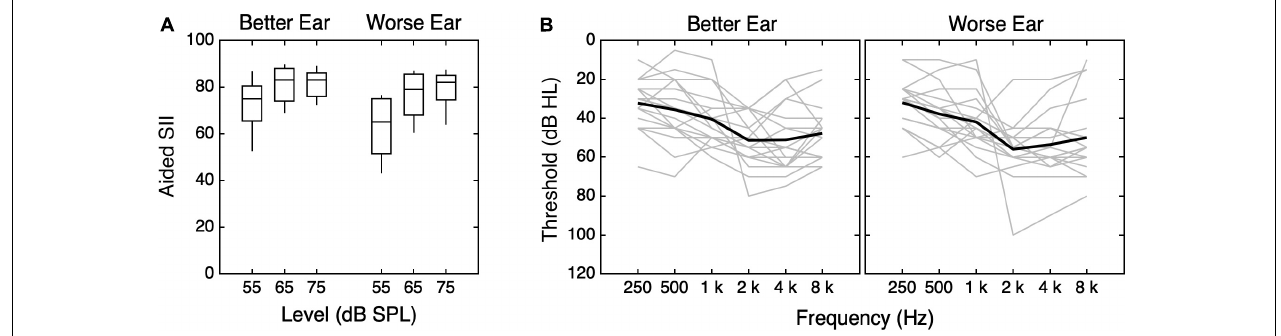
FIGURE 3 | Values of (A) SII and (B) pure-tone thresholds for children with hearing loss (CHL). (A) The distribution of SII is plotted as a function of stimulus level, with results shown separately for the better and worse ears, as indicated at the top of the panel. Horizontal lines indicate the median, boxes span the 25th to 75th percentiles, and vertical lines span the 10th to 90th percentiles. (B) Pure-tone thresholds for the better and worse ears are shown. Better and worse ear were identified for each subject based on SII55. Better-ear thresholds are shown in the left panel, and worse-ear thresholds are shown in the right panel. Individual data are shown in gray, and means are shown with thick black